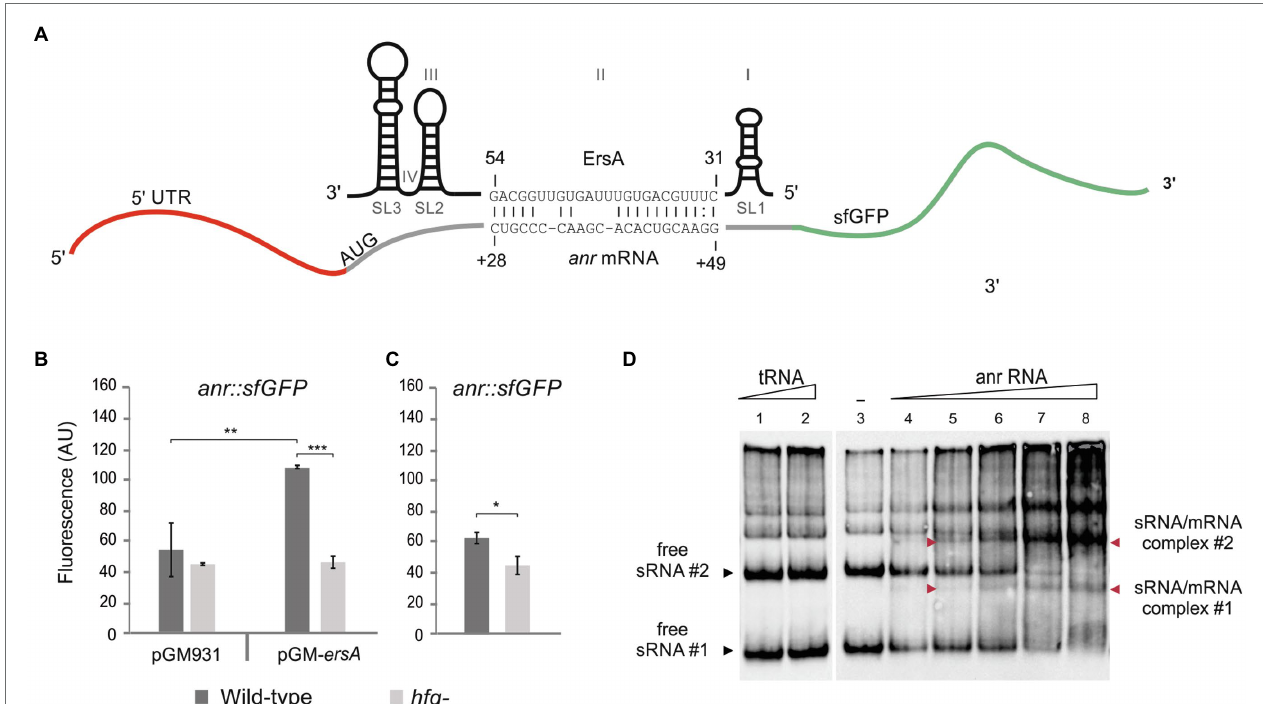
FIGURE 1 | Interaction of ErsA with anr mRNA. (A) The sRNA ErsA consists of four domains named I, II, III, and IV, and three steam and loop structures called SL1, SL2, and SL3. ErsA is predicted to bind to anr mRNA using part of its U-rich unstructured domain II that locates between the two stem and loop structures SL1 and SL2. The ErsA region from nt 31 to nt 54 is predicted to bind within the coding sequence of anr mRNA, from nt +28 to +49 downstream the translation start site (ATG) by IntaRNA software. (B) Comparison of the fluorescence polarization expressed in arbitrary units (AU) resulting from the translational fusion anr::sfGFP in aerobically grown planktonic PAO1 wild-type (dark gray bars) and PAO1 hfq − (light gray bars) cells, in the absence (pGM931) and the presence (pGM- ersA ) of ErsA overexpression. In the PAO1 wild-type background, ErsA overexpression from pGM- ersA results in an increase of the reporter activity compared to PAO1 harboring the empty vector pGM931. The absence of the molecular chaperone Hfq results in a lack of reporter activation by ErsA overexpression compared to wild-type. Significance by one-way ANOVA with post-hoc Tukey’s honestly significant difference is indicated: * p < 0.05; ** p < 0.01; and *** p < 0.001. (C) Comparison of the fluorescence polarization expressed in arbitrary units (AU) resulting from the translational fusion anr::sfGFP in PAO1 wild type (dark gray bars) and PAO1 hfq − (light gray bars) without ErsA overexpression. The lack of Hfq in the presence of ErsA levels that do not stimulate anr::sfGFP results in the reduction of the reporter activity. Statistical significance by t-test is indicated as: * p < 0.05. (D) In vitro interaction between ErsA RNA and anr mRNA by an electrophoretic mobility shift assay. 0.3 pmol of ErsA RNA was incubated at 37 ° C for 20 min with increasing amounts of anr RNA (0, 0.3, 0.6, 1.08, 2.1, and 4.2 pmol; lanes 3–8) or, as a negative control, yeast tRNA (1 and 4 pmol; lanes 1 and 2) and loaded into a native 6% polyacrylamide gel. Nucleic acids were transferred into GeneScreen plus nylon hybridization membranes. The sRNA/mRNA interactions were tested using biotinylated oligonucleotide probes pairing with the ErsA RNA. Free ErsA shows multiple electrophoretic forms. With the addition of the target RNA, free ErsA bands #1 and #2 disappear (black arrowheads #1 and #2), and other bands corresponding to the sRNA/mRNA complexes appear (red arrowheads #1 and